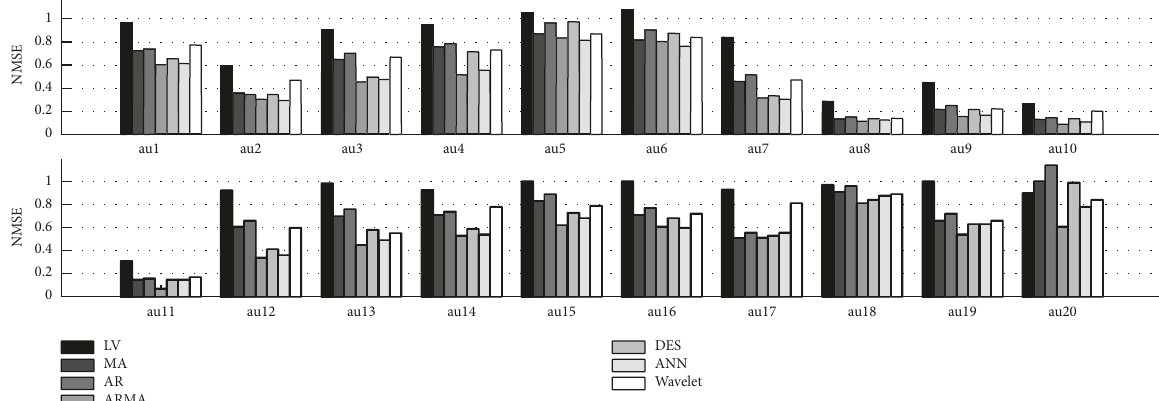
Figure 7: Normalized mean square error of different predictors for University of Auckland traces. The prediction interval used is 100